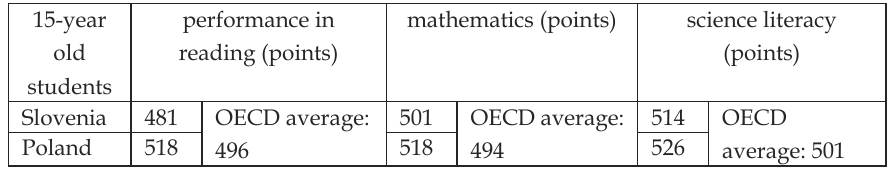
Table 1. The results of PISA 2012 in Slovenia and